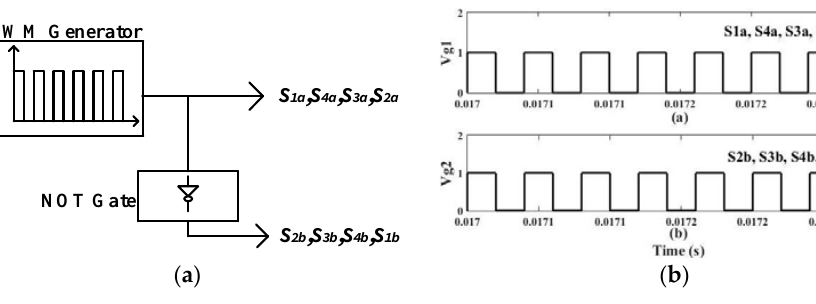
Figure 7. ( a ) PWM Controller; ( b ) Simulation results of pulses i.e., V g1 and V g2 (180° out of phase).